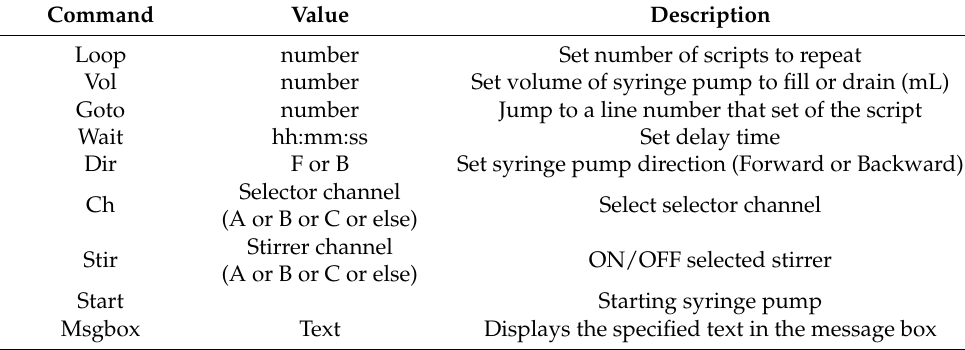
Figure 6. Schematic diagram showing workflow of controlling program. Table 1. List of commands for controlling